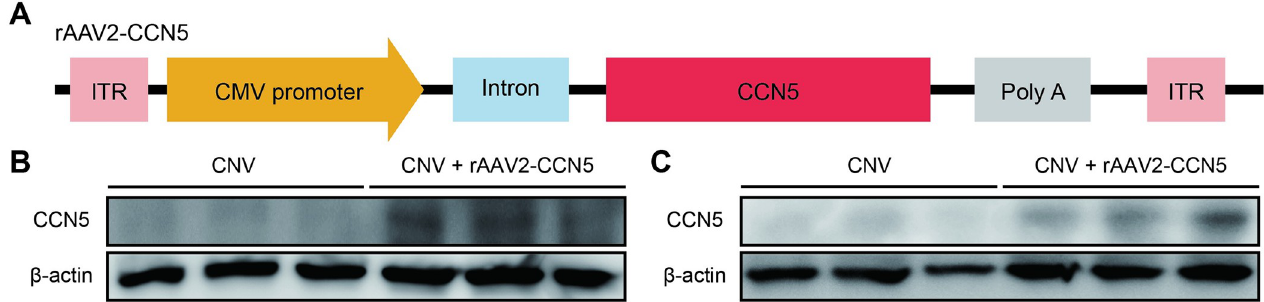
Fig 1. Design and validation of rAAV2-CCN5. (A). A schematic representation of rAAV2-CCN5. ITR, inverse terminal repeat. (B, C). CCN5 expression was determined via western blotting from retina and RPE/choroid complex. (n = 3~6 mice per group).